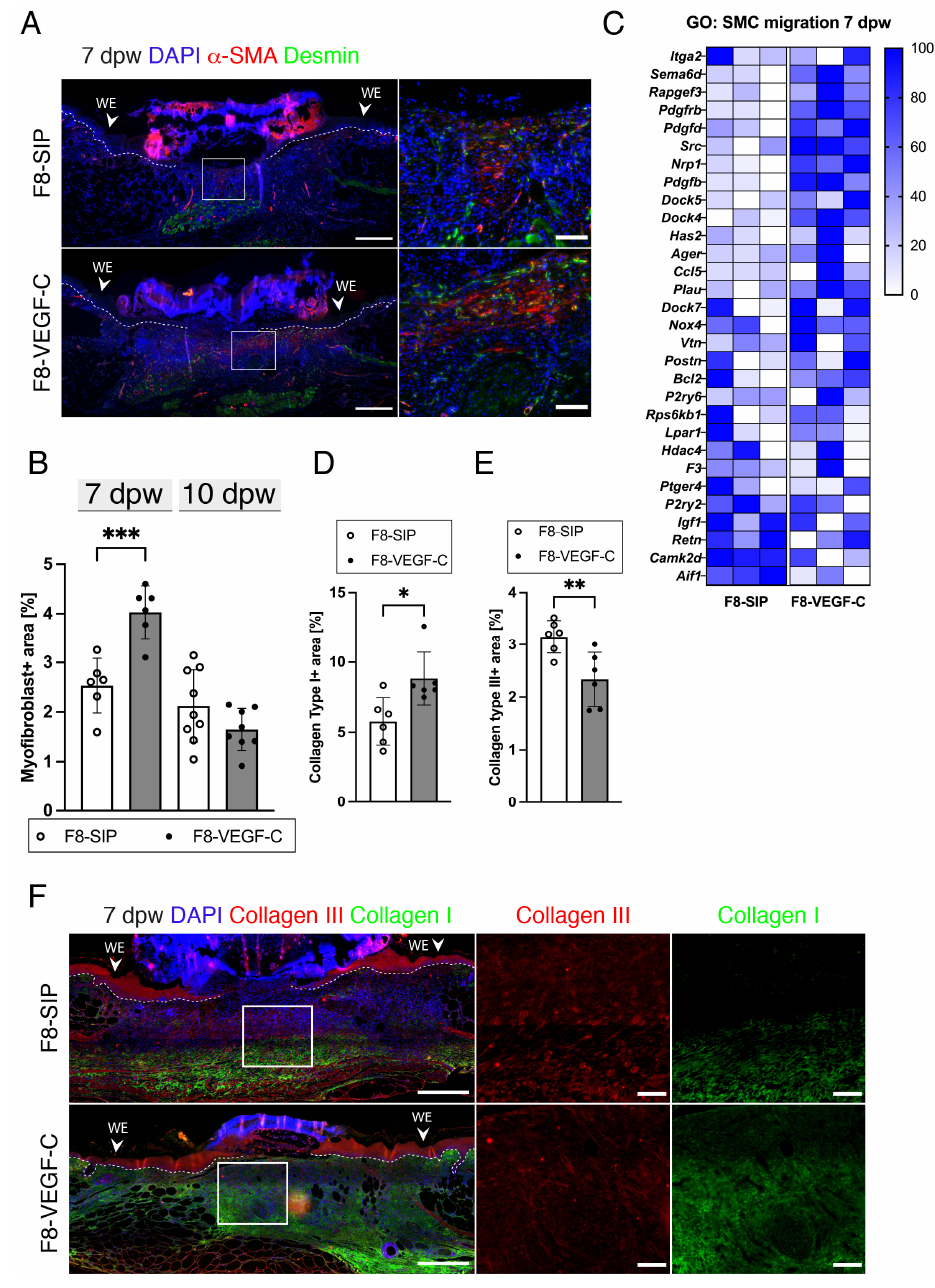
Figure 8. Targeted delivery of VEGF-C increases myofibroblast density and collagen I deposition in diabetic wounds. ( A ) Representative α -SMA and desmin stained sections of F8-SIP- and F8–VEGF-C-treated db/db mice at 7 dpw. Enlarged images showing more abundant myofibroblasts in the center of the F8–VEGF-C-treated wounds compared to the F8-SIP-treated wounds. Scale bars: